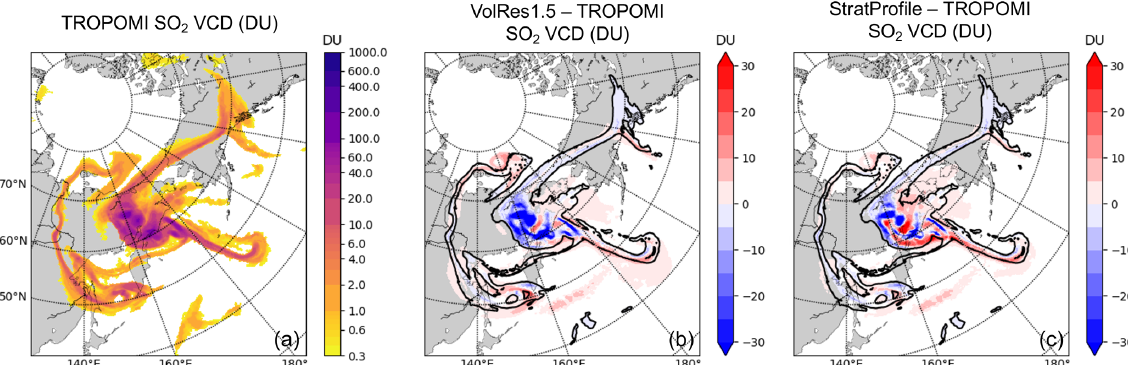
Figure 7. The spatial pattern of the volcanic SO 2 cloud as retrieved by the TROPOMI satellite for the 27 June 2019 (panel a ). Panels (b) and (c) show the difference (in DU) with the VolRes1.5 and the StratProfile simulation respectively. Only SO 2 VCD values above 1DU are shown. The contour shows the outline of the SO 2 cloud in TROPOMI for a SO 2 VCD of